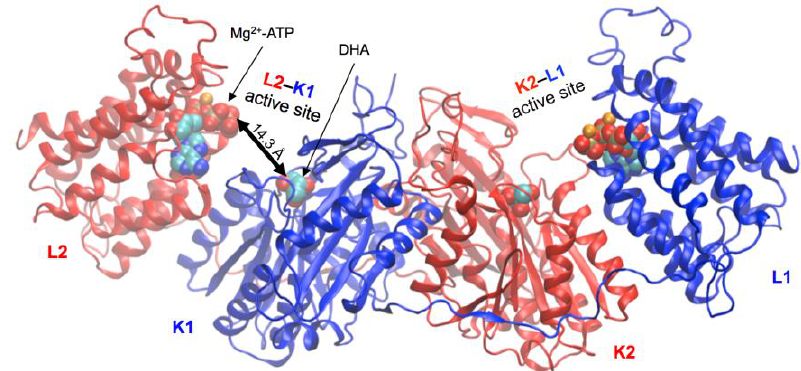
Figure 1. Homology model of human triokinase/flavin mononucleotide (FMN) cyclase (hTKFC) in complex with dihydroxyacetone (DHA), adenosine triphosphate (ATP) and Mg 2+ (hTKFC:2DHA:2ATP). The ATP-to-DHA distance is indicated in the L2-K1 site. The description is in the text. The figure was drawn according to the coordinates reported elsewhere [2].